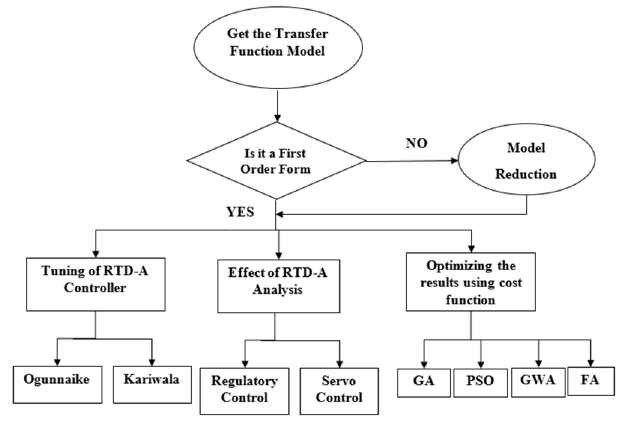
Figure 2. Flowchart for the simulation tool design.